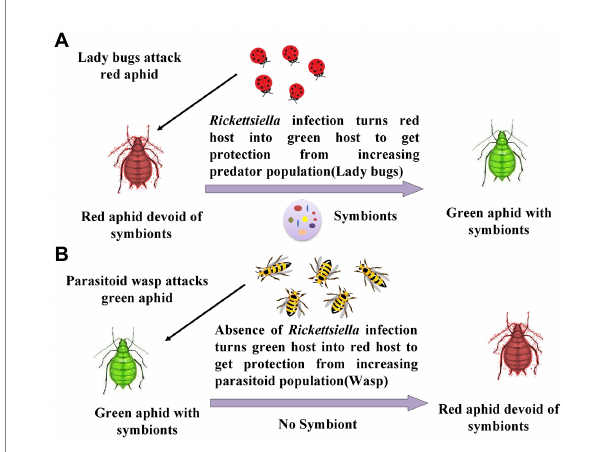
FIGURE 6 Change in body color in response to acquisition by Rickettsiella: (A) When red aphids are attacked by predators like ladybird beetle, there is the accumulation of gut symbionts Rickettsiella, which turn red aphids into green aphids; (B) When green aphids are attacked by parasitoid like wasps, the population of Rickettsiella get reduced turning green aphids into red aphids (Libbrecht et al., 2007; Tsuchida et al.,